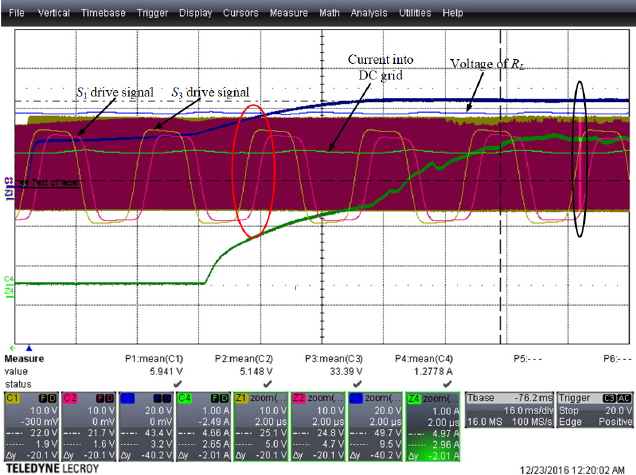
Figure 27. Waveform with R L voltage 43